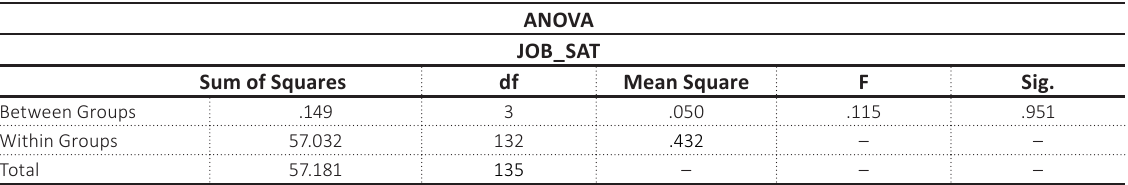
Table 15. One-way ANOVA test for education level